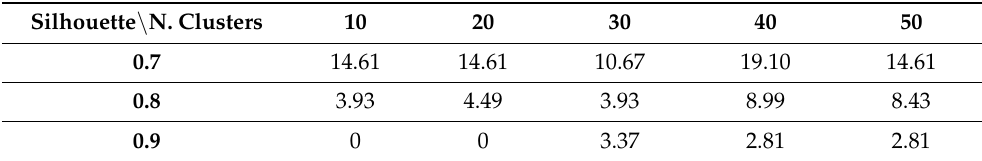
Table 30. Clustering performance in terms of silhouettes using the reduced dataset with SPQR applied to normalized data. Silhouette \ N.